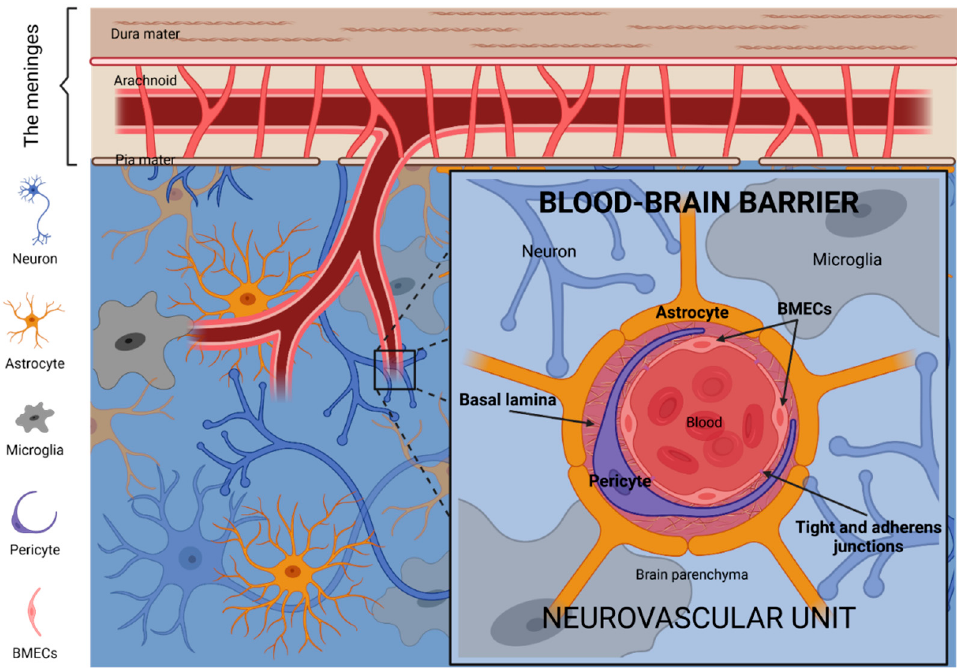
Figure 1. The blood–brain barrier (BBB). The neurovascular unit is the principal anatomical and functional structure of the BBB. BMECs, thoroughly closed between them by tight and adherens junctions, and surrounded by large pericytes and the basal lamina matrix, constitute the vessels of the neurovascular unit. Neurons, microglia and the endfeet of astrocytes constitute the microenvironment which supports and communicates with the vessel components of the neurovascular unit. Image created with BioRender.com (accessed on 17 June 2021).